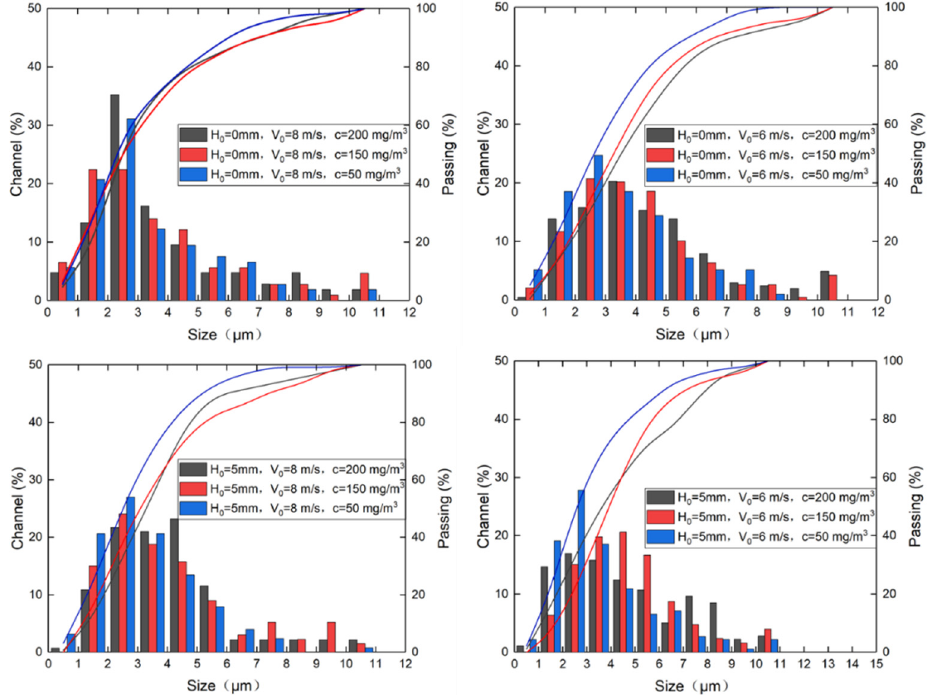
Figure 6. Size distributions of tobacco dust particles after purification under 12 different conditions.